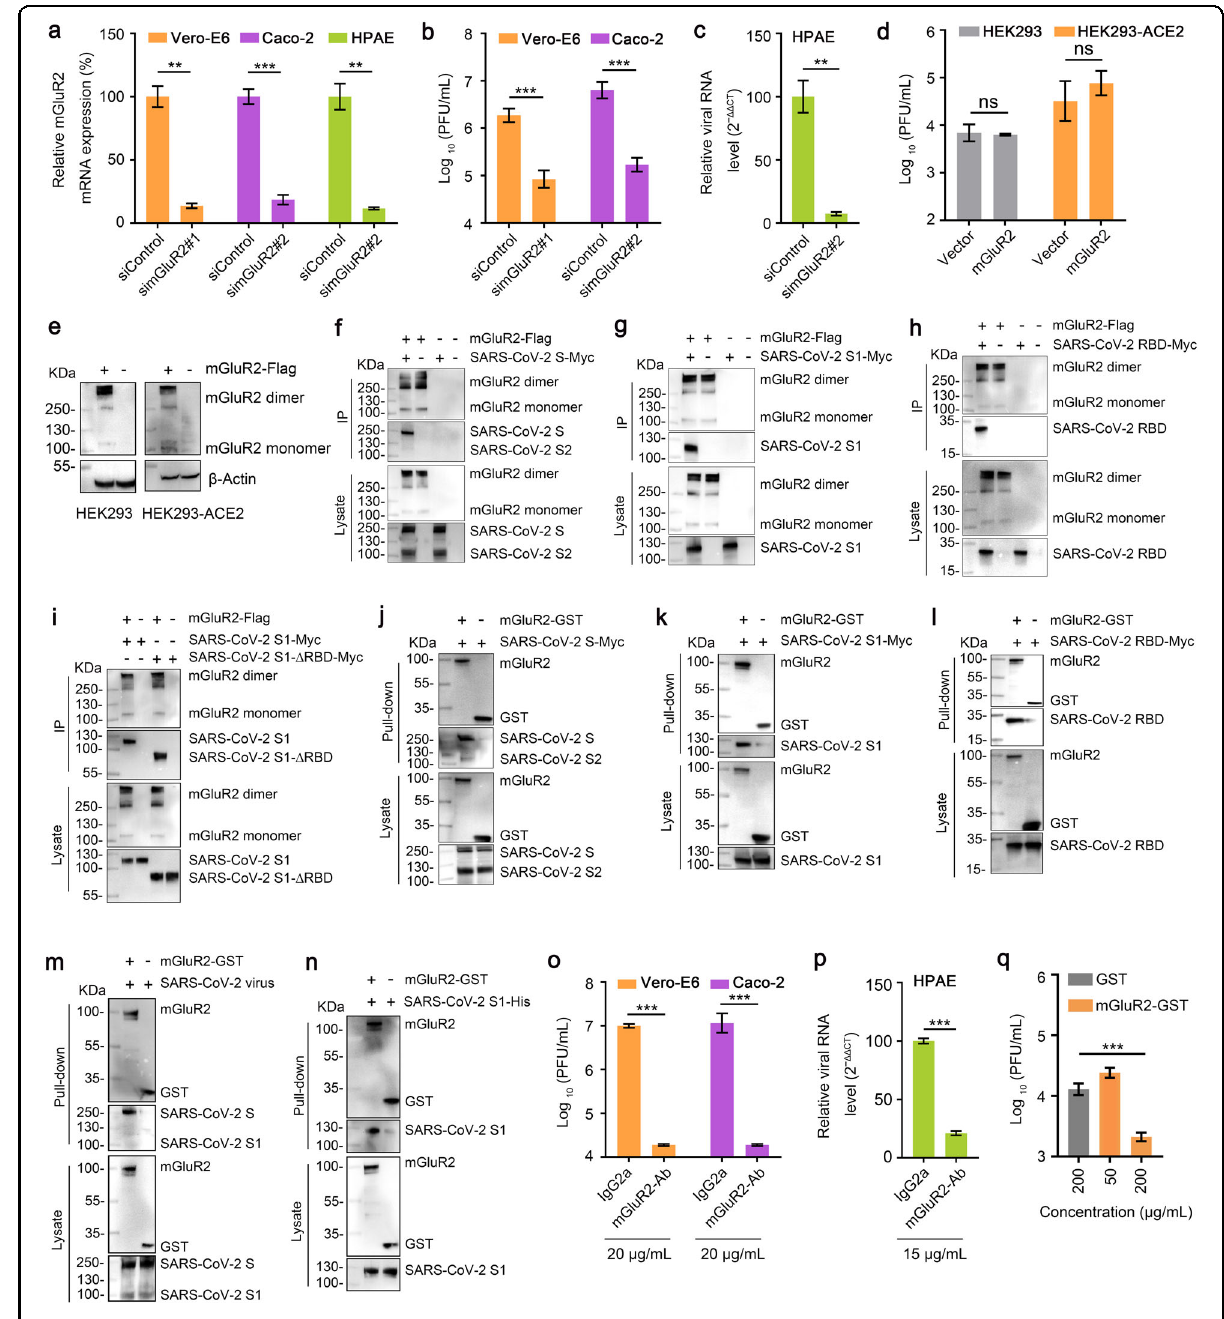
Fig. 1 (See legend on next